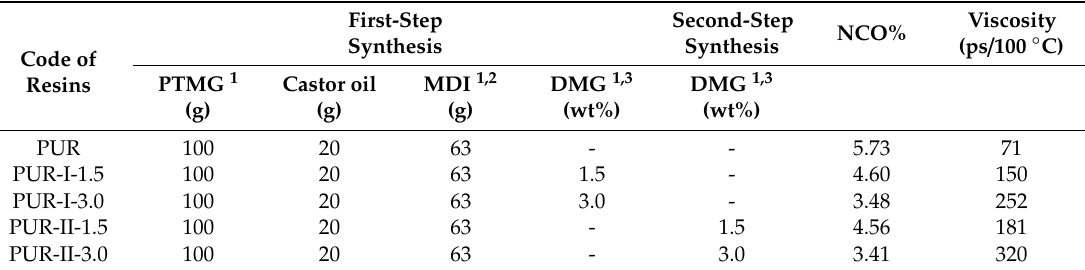
Table 1. Basic properties of various